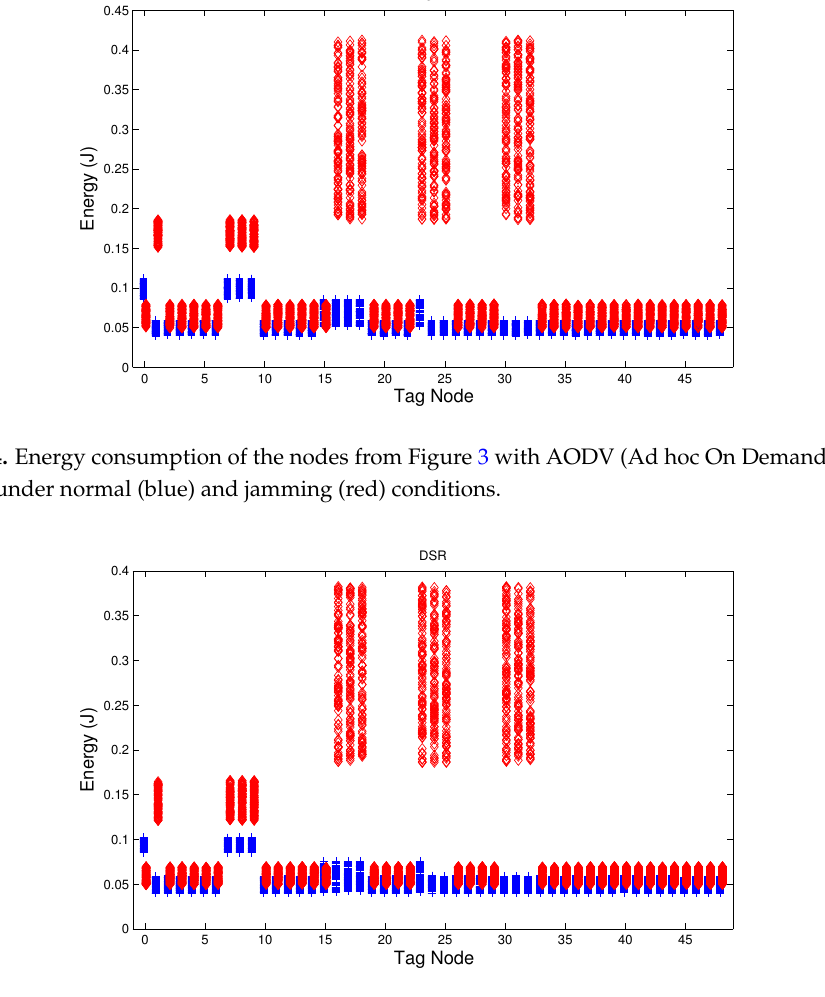
Figure 5. Energy consumption of the nodes from Figure 3 with DSR (Dynamic Source Routing) under normal (blue) and jamming (red) conditions.